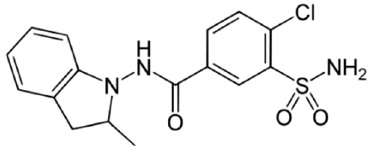
Figure 1. Chemical structure of indapamide.